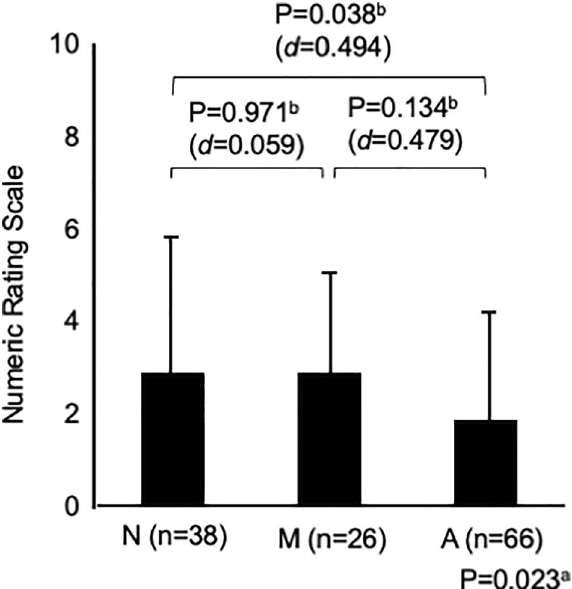
Figure 4. Comparison of symptom improvement among the three groups after 4 weeks of proton pump inhibitor administration: Global assessment scale. NOTE: a = analysis of variance, b = Tukey’s honestly significant difference test, d = Cohen’s